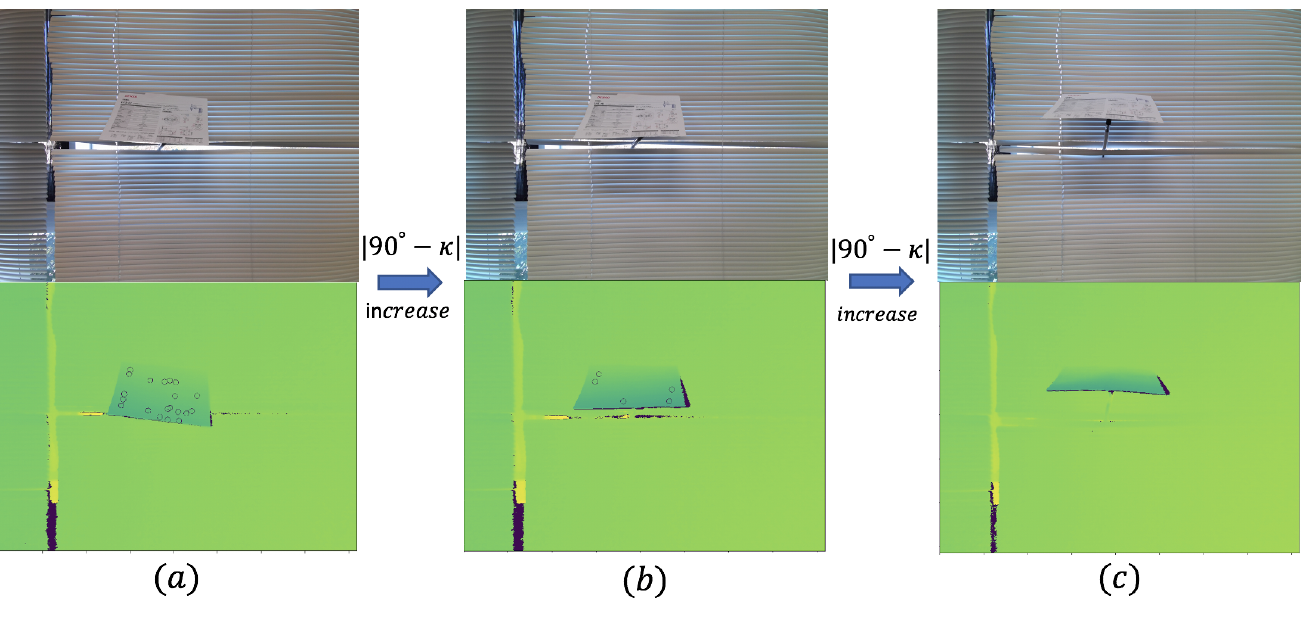
Figure 21. Change in tilt angle: increasing | 90 ◦ − κ | as ( a ) → ( b ) → ( c ) .